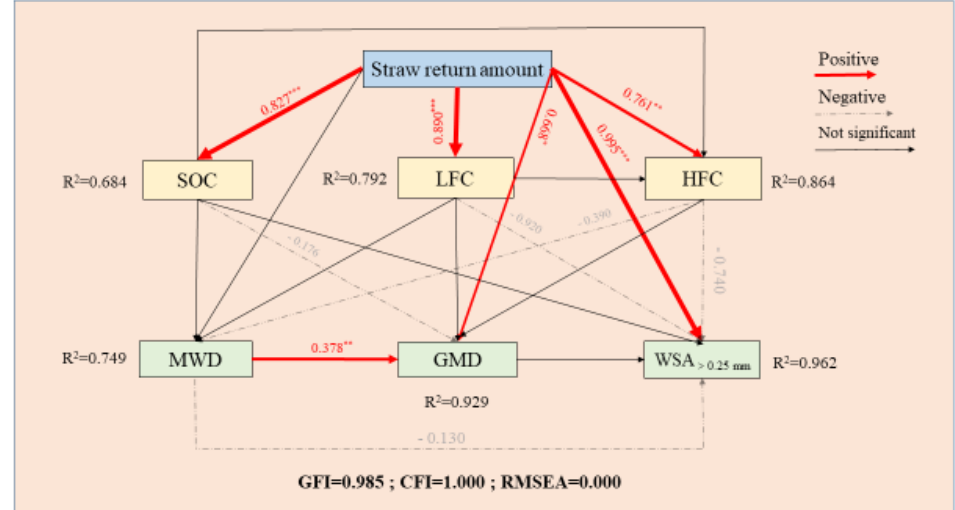
Figure 5. Structural equation model of the relationships among straw return, soil organic carbon indicators, and aggregate indicators. Red lines indicate positive relationships, dashed black lines indicate negative relationships, and black lines indicate non-significant relationships. Numbers associated with the lines are correlation coefficients. Arrow width indicates the strength of significant standardized path coefficients. R 2 above each response variable in the model denotes the proportion of variance explained. *, p < 0.05; **, p < 0.01; ***, p < 0.001; SOC, soil organic carbon; LFC, light fraction carbon; HFC, heavy fraction carbon; MWD, mean weight diameter; GMD, geometric mean diameter; WSA >0.25mm , >0.25mm water-stable aggregates; GFI, goodness-of-fit; CFI, comparative fit index; RMSEA, root mean square error of